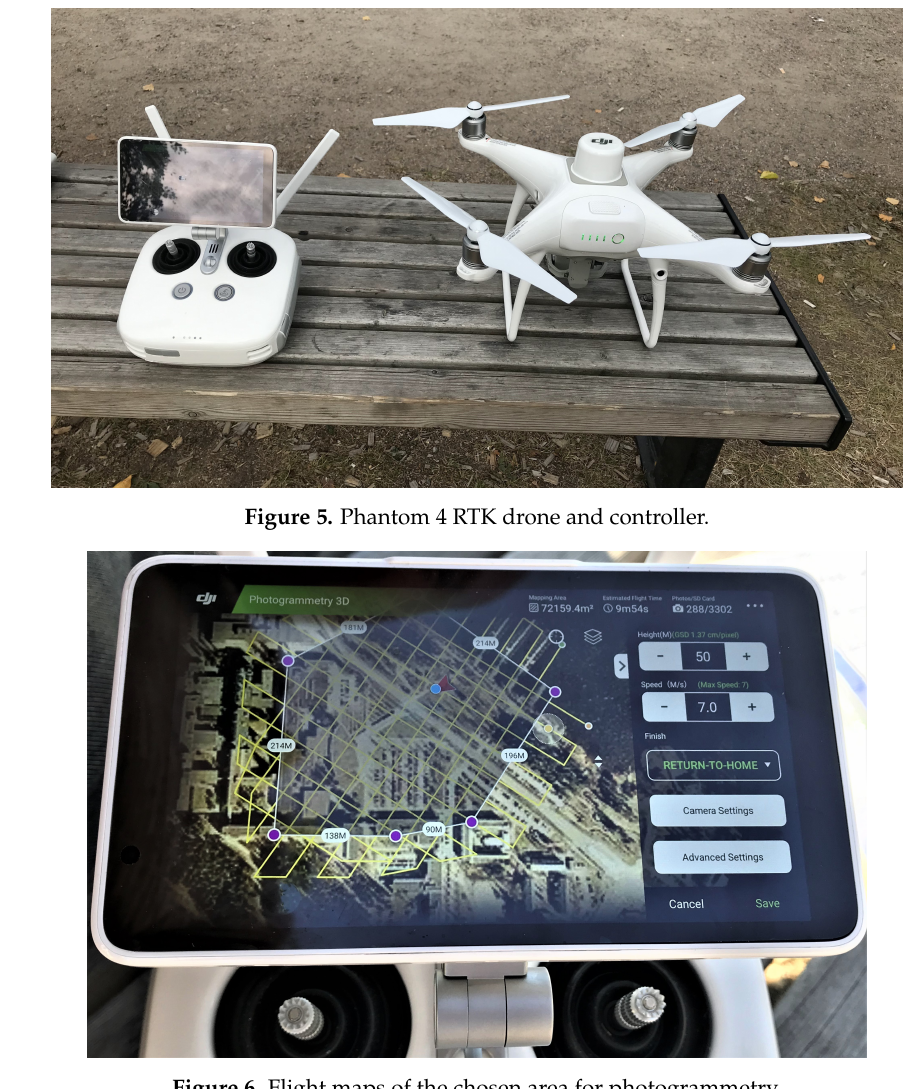
Figure 6. Flight maps of the chosen area for